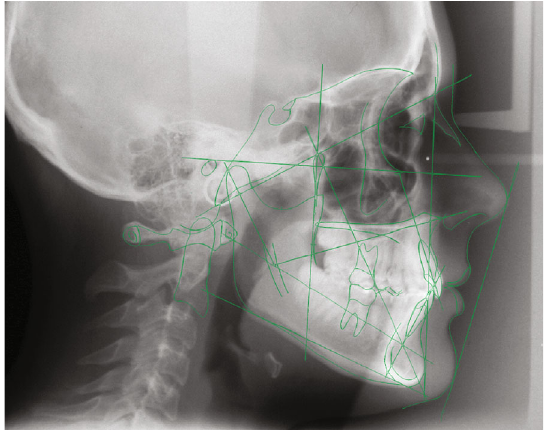
Figure 12: 2-year follow-up lateral cephalogram.